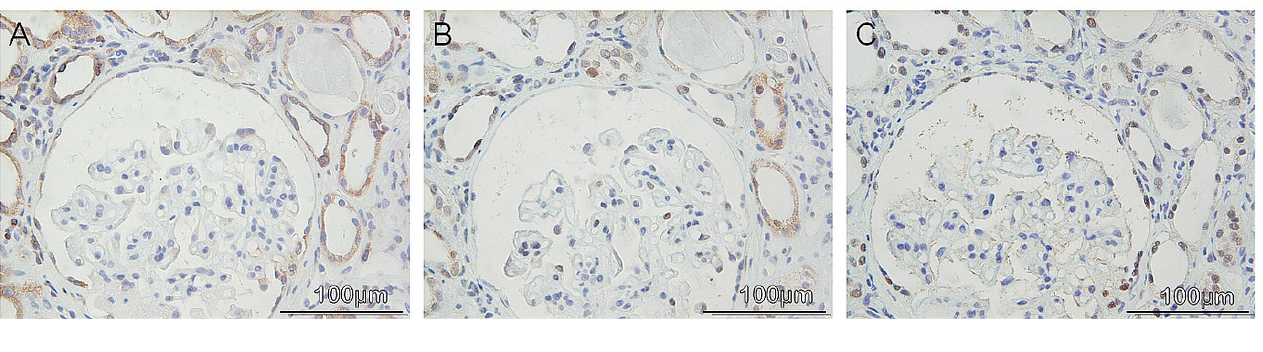
Figure 6. Immunohistohemical detection of BCL-2, p53 and PAX8 kidney biopsies. ( A ). BCL-2; ( B ). p53; ( C ).